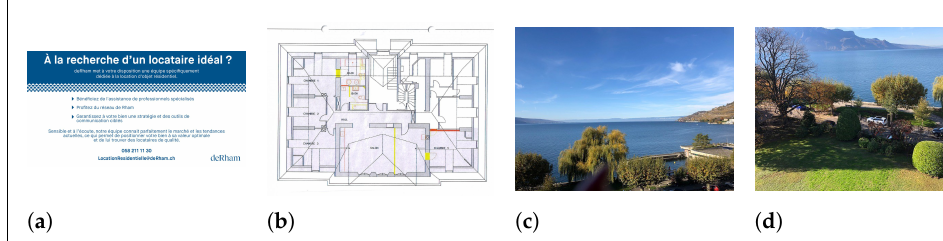
Figure 2. Examples of irrelevant images in stages 1 and 2: logo ( a ), layout scheme ( b ) and irrelevant exterior images ( c , d